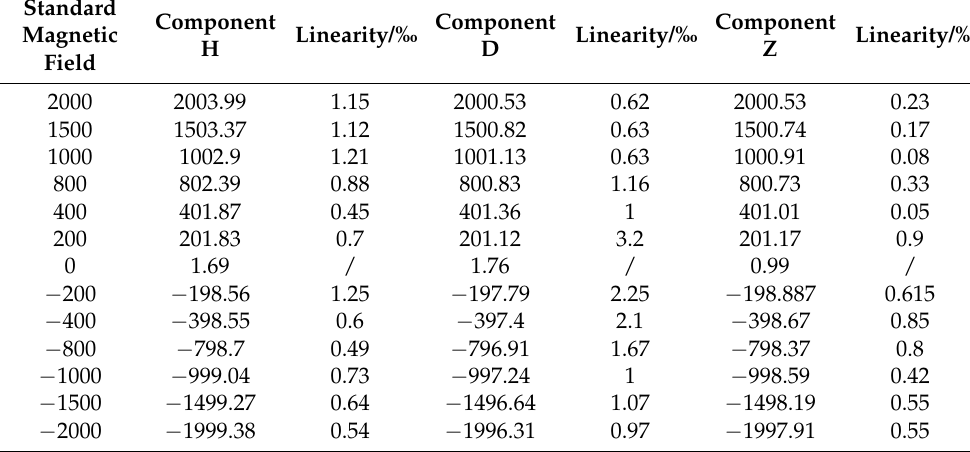
Table 2. Linearity test results. All magnetic field values are given in nanoteslas .